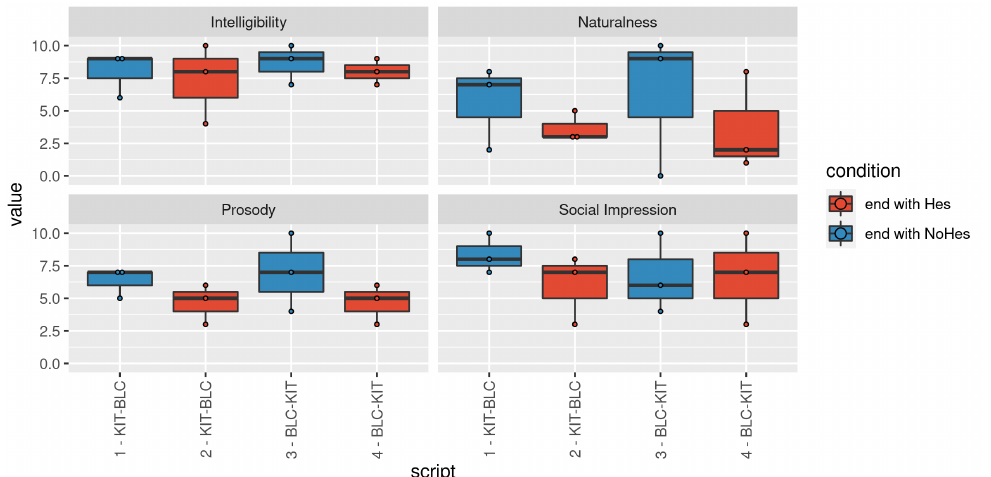
Figure 12. Synthesis quality separated by